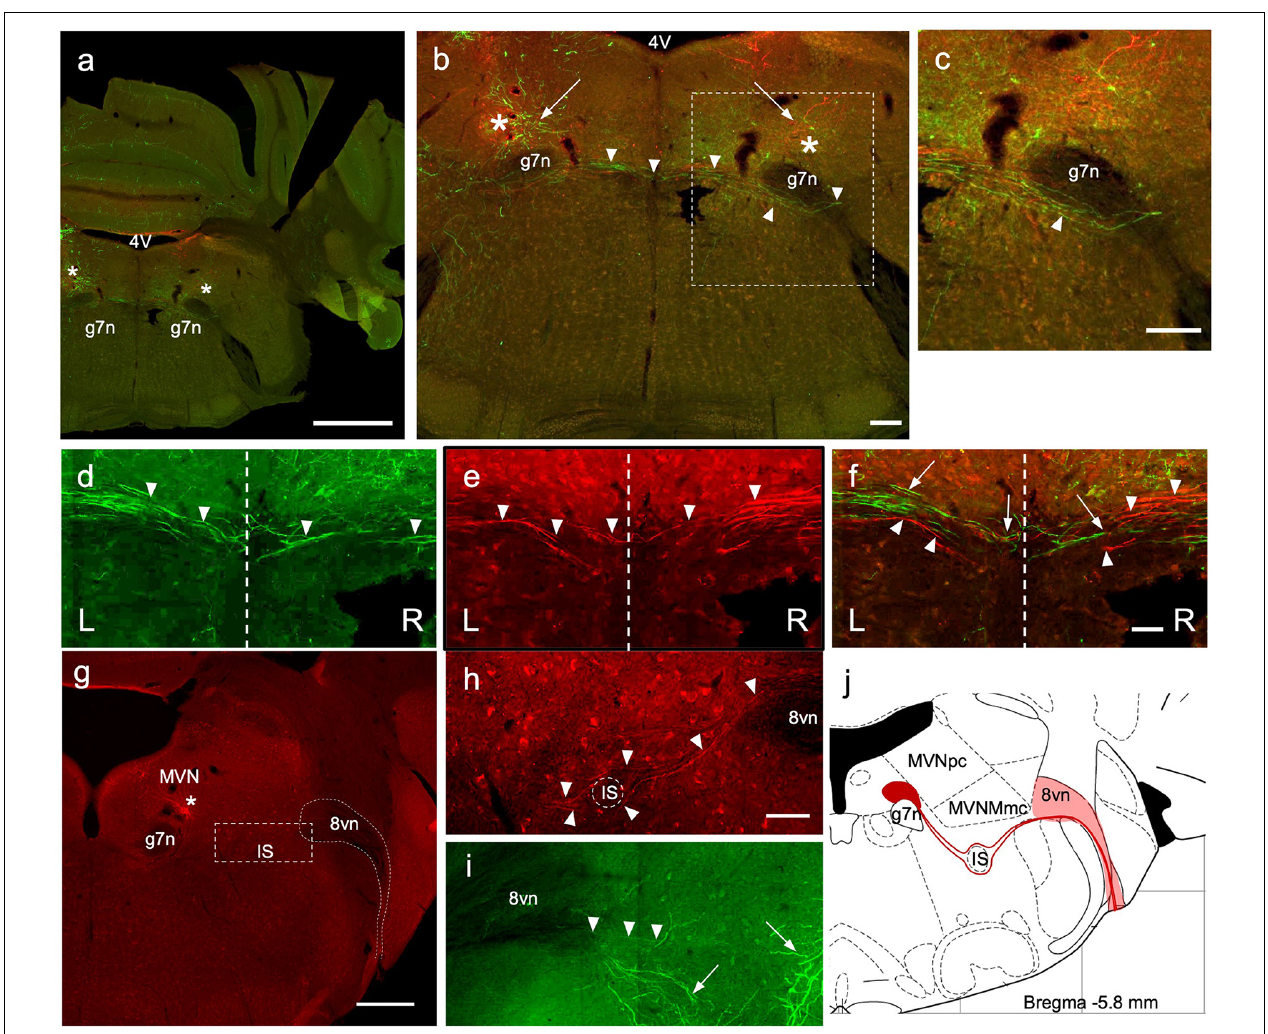
FIGURE 4 | Crossing EVN fibers. (A) Photo-merged image of a transverse brainstem section at the level of the crossing fibers. The right-side cerebellum was nicked before sectioning for orienting. 4V—4th ventricle, 7n—genu of the facial nerve. Asterisks represent a projected area where EVN cell bodies would be in more caudal slices. Scale bar: 1 mm. (B) Virally induced fluorescent efferent axons crossing the midline (arrowheads). 4V—4th ventricle, arrows—level of the EVN and fluorescent branches, 7n—genu of the facial nerve. Scale bar: 100 µ m. (C) Higher magnification of “b” dashed box, showing the trajectory of contralateral efferent axons after crossing the midline, going underneath (arrowhead) the genu of the 7th nerve (g7n) and heading towards the eighth nerve exit. (D–F) Green and red efferent axonal fibers, originate from the left and right EVN, respectively, and cross the midline (dashed line) of the brainstem. Arrowheads point to crossing fibers. In composite panel (F) . Arrows—green (left) fibers; arrowheads—red (right) fibers. Scale bar (D–F) : 50 µ m. L = Left, R = Right. Scale bar: 100 µ m. (G–J) Low magnification (G) of the right side (red) showing labeled red fluorescent EVN cell bodies (below the asterisk) located near blood vessels. Since there are fewer ipsilateral axons, they were harder to trace than contralateral axons. Nevertheless, we saw ipsilateral axons descend ventrally ( I ; green) and then re-ascend, dorsally ( H ; red). As the ipsilateral axon bundle ascends it divides around the inferior salivary nucleus (G,H) on its way to the vestibular root of the vestibulocochlear